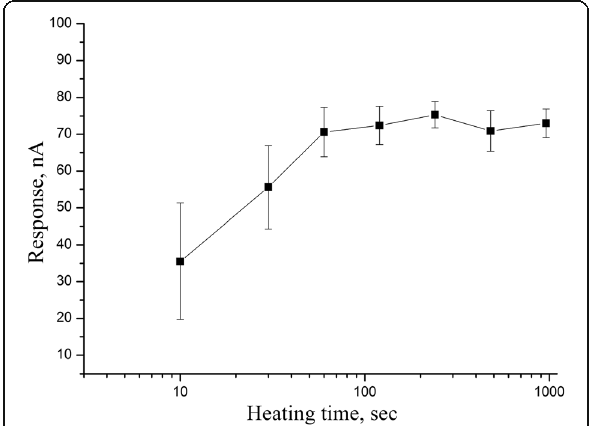
Fig. 4 Dependence of responses of biosensor based on GlOx, adsorbed on silicalite, on the time of silicalite deposition on transducer. Measurements in 20 mM HEPES buffer, pH 7.4, at a constant potential of +0.6 V vs Ag/AgCl reference